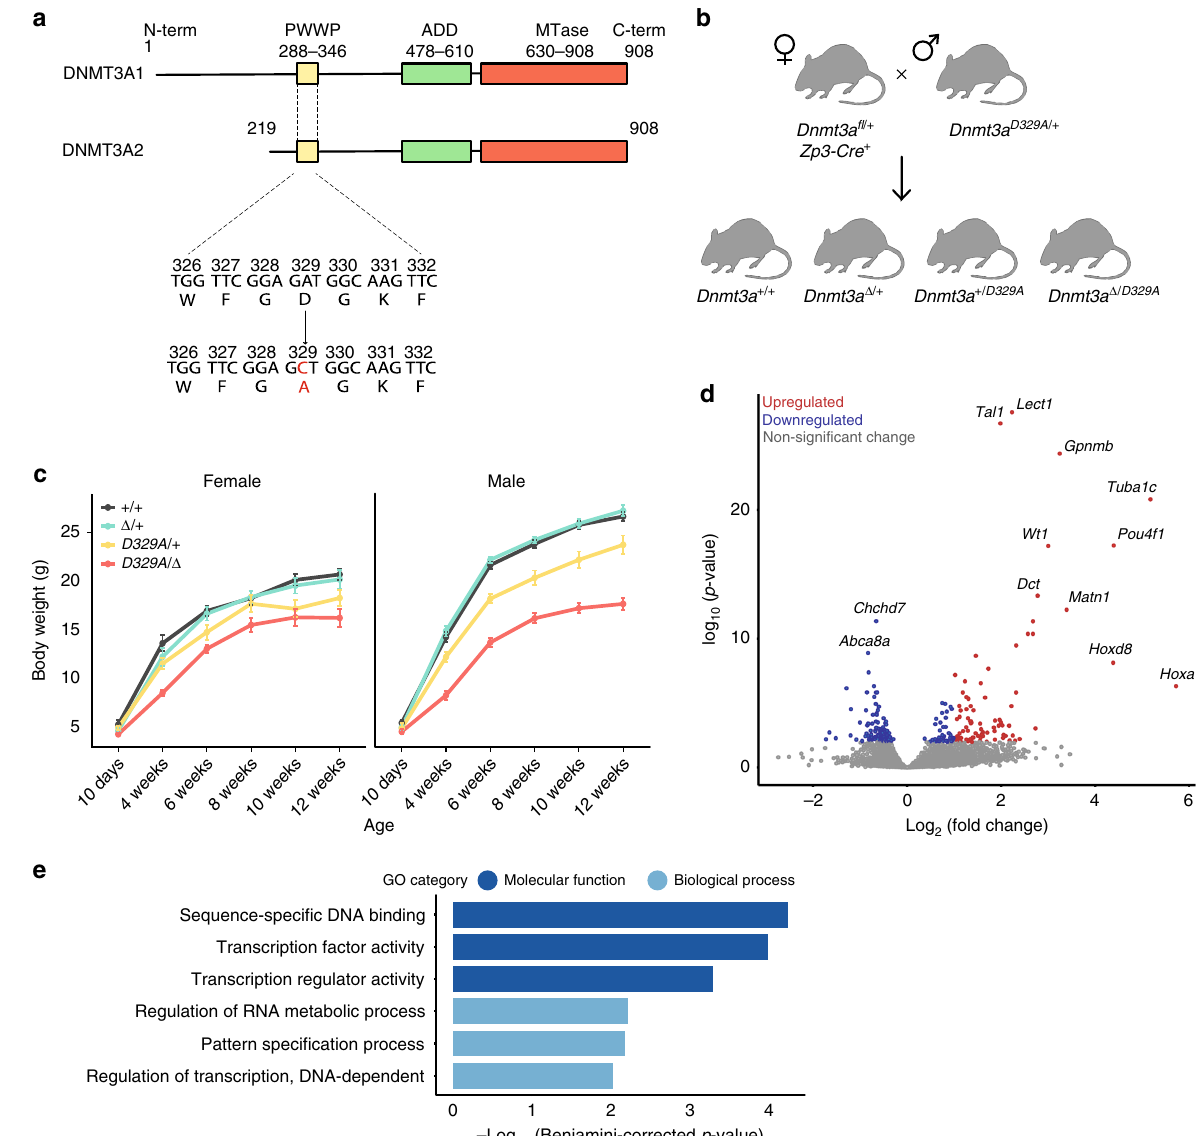
Fig. 1 Phenotypic description of mice carrying the Dnmt3a D329A allele. a Schematic representation of the DNMT3A protein isoforms and location of the base substitution, coloured red, introduced to generate the D329A mutation. NCBI IDs: CCDS36397.1, CCDS25784.1. Known domains are indicated by coloured boxes, based on the PROSITE database; numbers indicate amino acid residues. b Breeding scheme used to generate offspring of four different genotypes. + ; wild-type allele; fl : Dnmt3a containing loxP sites surrounding exon 18; Δ : loxP sites after recombination leading to deletion of exon 18; Zp3 - Cre : oocyte-speci fi c Zp3 promoter-driven Cre recombinase 21,22 ; D329A : a Dnmt3a allele point missense mutation in exon 8. c Growth curves indicating change in body weight of male and female mice of different genotypes over the indicated post-natal weeks. Mixed model ANOVA (KR-method) shows overall signi fi cant change dependent on genotype and time in both sexes ( p < 0.001, df(males) = 15,229.48, df(females) = 15,142.15), F = 0). Subsequent pairwise Bonferroni-adjusted t -test comparisons show that Dnmt3a Δ /D329A males become signi fi cantly underweight at week 4 ( p < 0.001), and Dnmt3a + /D329A at week 6 ( p < 0.001). Dnmt3a Δ /D392A females become signi fi cantly underweight starting from week 4 ( p = 0.002), with the exception of week 8 ( p = 0.095). Dnmt3a + /D329A females do not show signi fi cant change. n values are given in Supplementary Table 3. Error bars indicate standard error of the mean. Raw data are provided in Source Data. d Volcano plot showing gene expression fold change and its signi fi cance between Dnmt3a + / + and Dnmt3a Δ /D329A adult (14-week) hypothalamus. Differentially expressed genes were determined using DEseq ( p < 0.01, Benjamini – Hochberg multiple comparisons correction). n ( + / + ) = 5, n( Δ /D392A ) = 4. Selected genes showing the most signi fi cant and highest fold change are named. e Gene ontology (GO) analysis of differentially expressed genes; only signi fi cant terms are shown. Benjamini – Hochberg corrected p -value < 0.1 was used as a Transcriptional de-repression in Dnmt3a Δ /D329A hypothala- adult (14-week) hypothalamus. The D329A allele did not cause a mus . DNMT3A plays a predominant role in de novo methylation statistically signi fi cant change in Dnmt3a transcript levels, or during postnatal neurogenesis 23,51 and the hypothalamus is affect the abundance of other Dnmt or Tet transcripts (Supple- involved in regulation of body weight through endocrine function, mentary Fig. 3). However, we identi fi ed 259 differentially feeding behaviour and energy homoeostasis 52,53 . We therefore expressed genes (DEGs) between Dnmt3a Δ /D329A and Dnmt3a + / + (Fig. 1d and Supplementary Data 1). Gene ontology (GO) analysis evaluated potential gene dysregulation by performing RNA-seq on